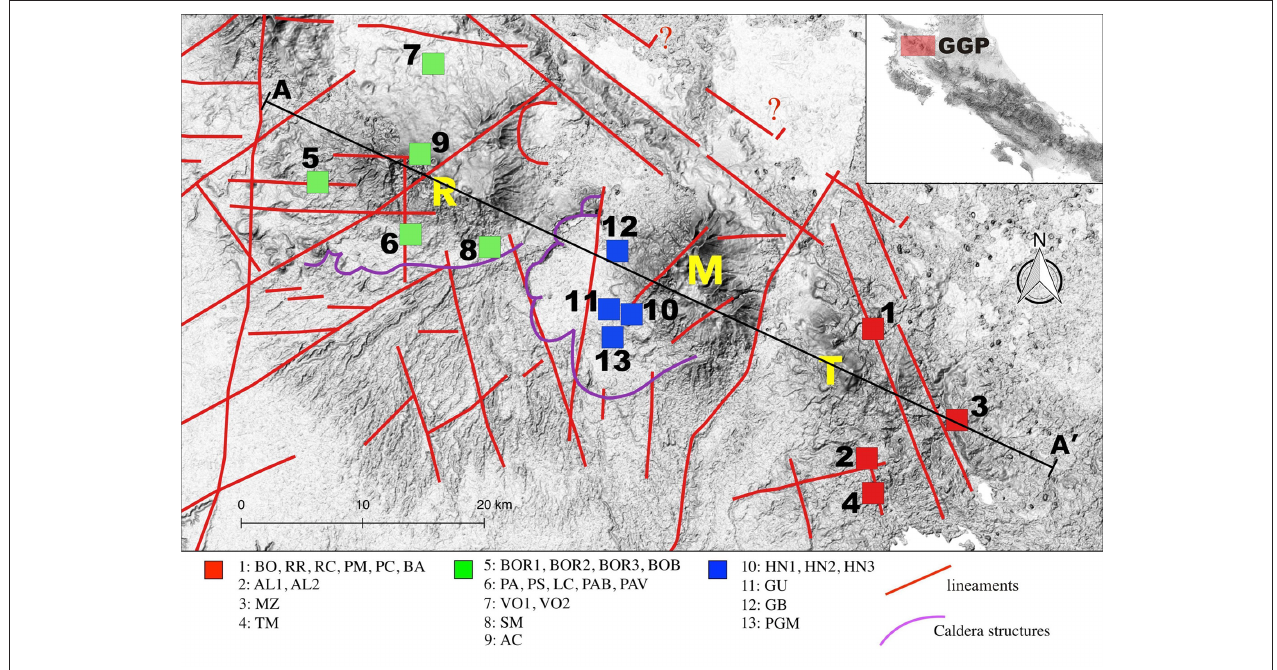
FIGURE 1 | Map of the Guanacaste region with the location of sampling sites. Green square: Rincón de la Vieja (R); blue square: Miravalles (M); red square: Tenorio